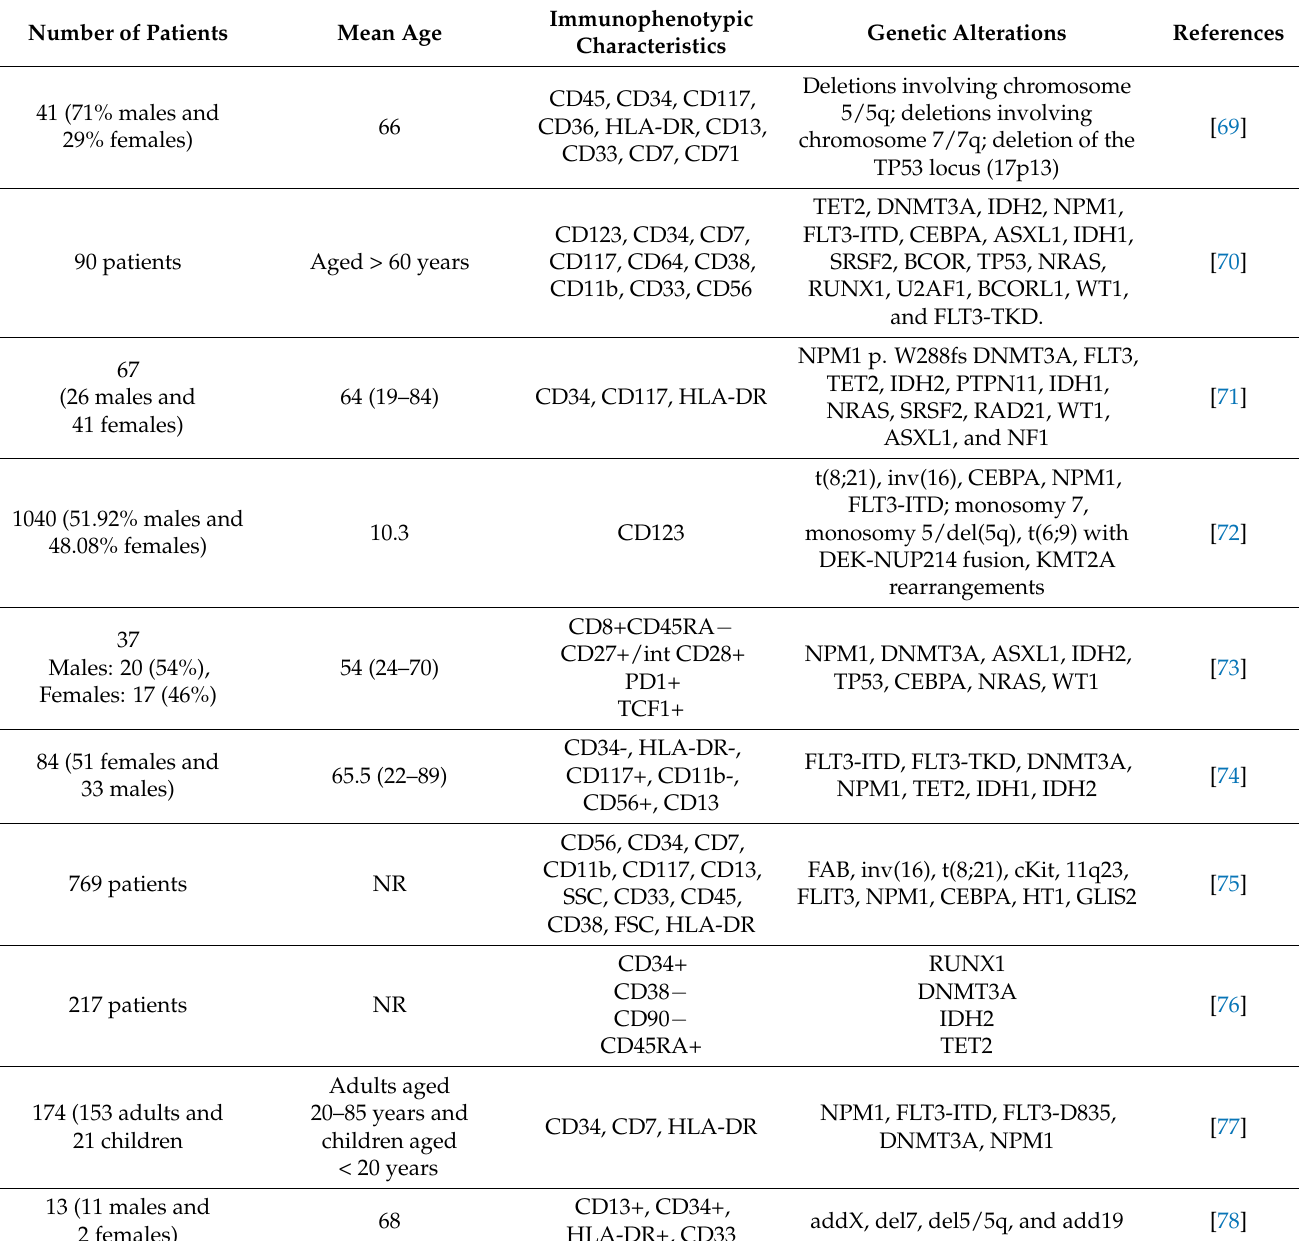
Table 1. Studies from the last 10 years indicating relationships between immunophenotyping and genetic changes in AML